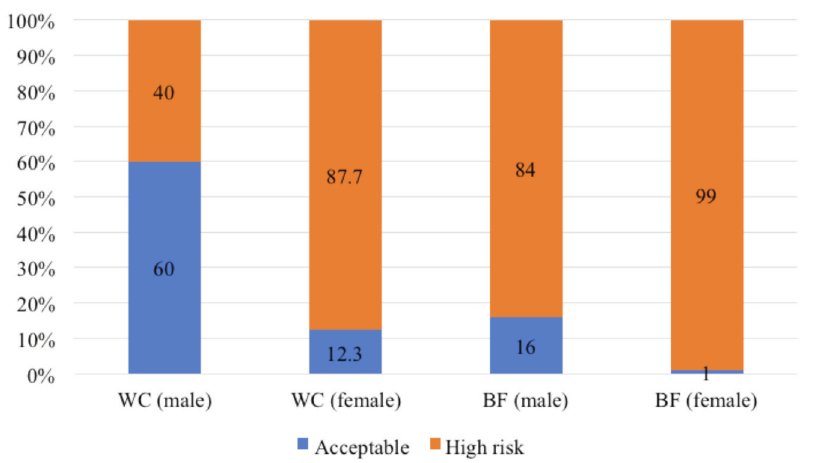
Percentage of WC and BF compared to cut-off value for male (n = 25) and female (n = Fig. 2: